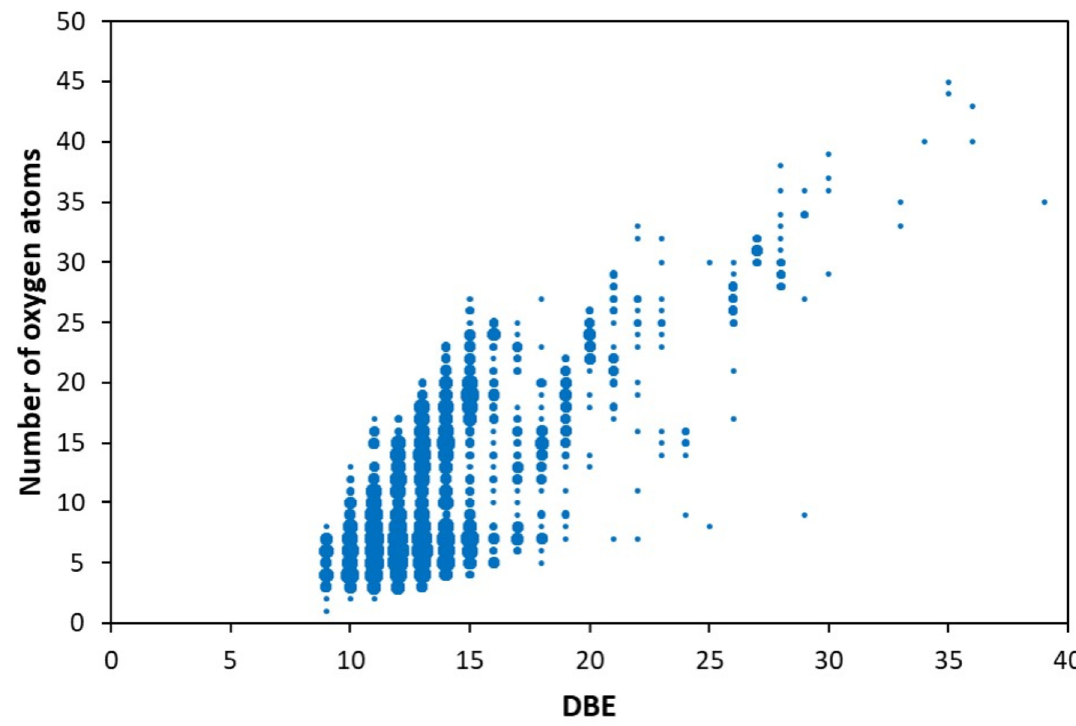
Figure 3. The DBE values and the number of oxygen atoms of the compounds in the flavonoid database [28,29]. The Pearson’s correlation coefficient r = 0.76.